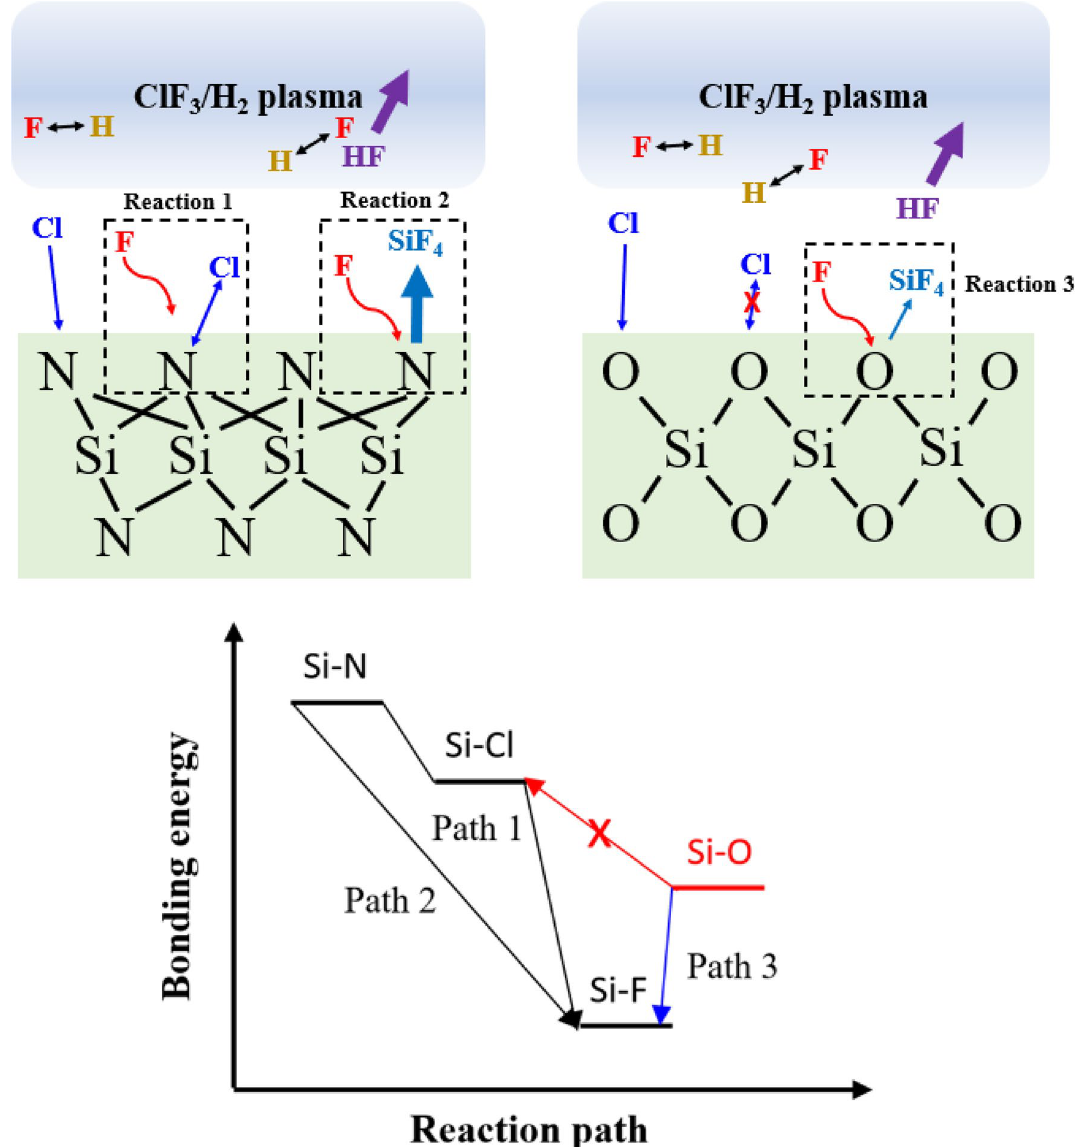
Figure 5. Schematic of chemical reaction of ClF 3 /H 2 remote plasma on etching of SiN x and SiO y . Possible reaction paths are